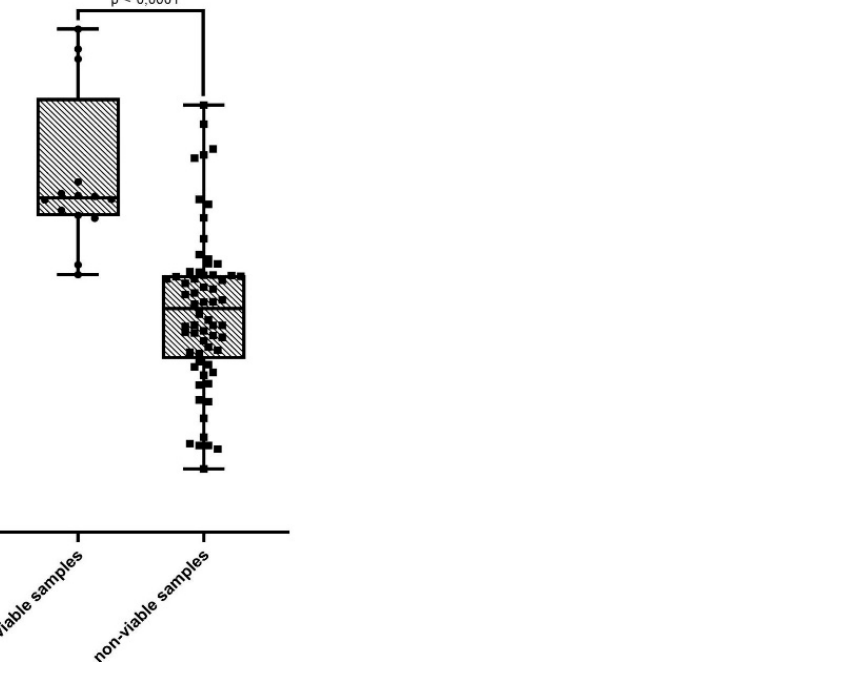
Figure 1. SARS-CoV-2 viral load in viable versus non-viable samples. Results are represented by a box plot: horizontal lines—medians; boxes—interquartile range; whiskers—min-max ( p -value calculated using Mann–Whitney test). Table 3. Viral load (copies/mL) depending on viability and rapid test